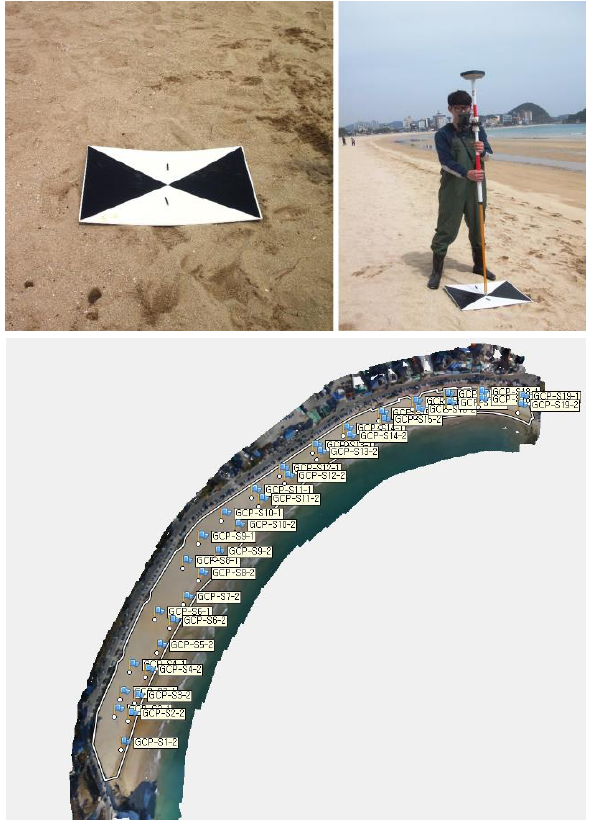
Figure 3. Set of GCP locations.